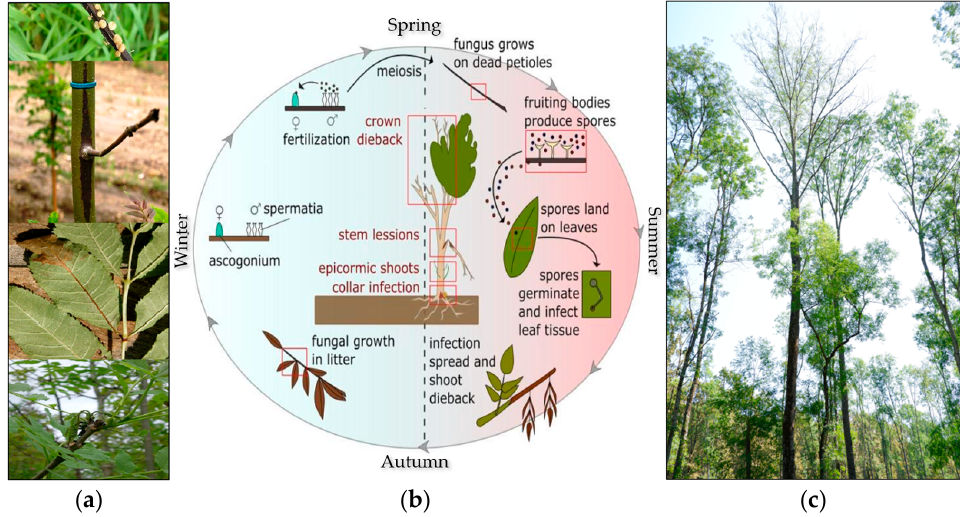
Figure 2. ( a ) Hymenoscyphus fraxineus disease symptoms: mushroom-like fruiting bodies (top); diamond-shaped lesions (middle upper); shoot wilting and leaf necrosis (middle lower and bottom) (source: Forest Research, www.forestresearch.gov.uk, accessed on 10 January 2023). ( b ) Lifecycle and symptoms (source: Teagasc—Agriculture and Food Development Agency, www.teagasc.ie, accessed on 10 January 2023) and ( c ) narrow-leaved ash ( Fraxinus angustifolia ) dieback; location Radinje forest, Croatia.